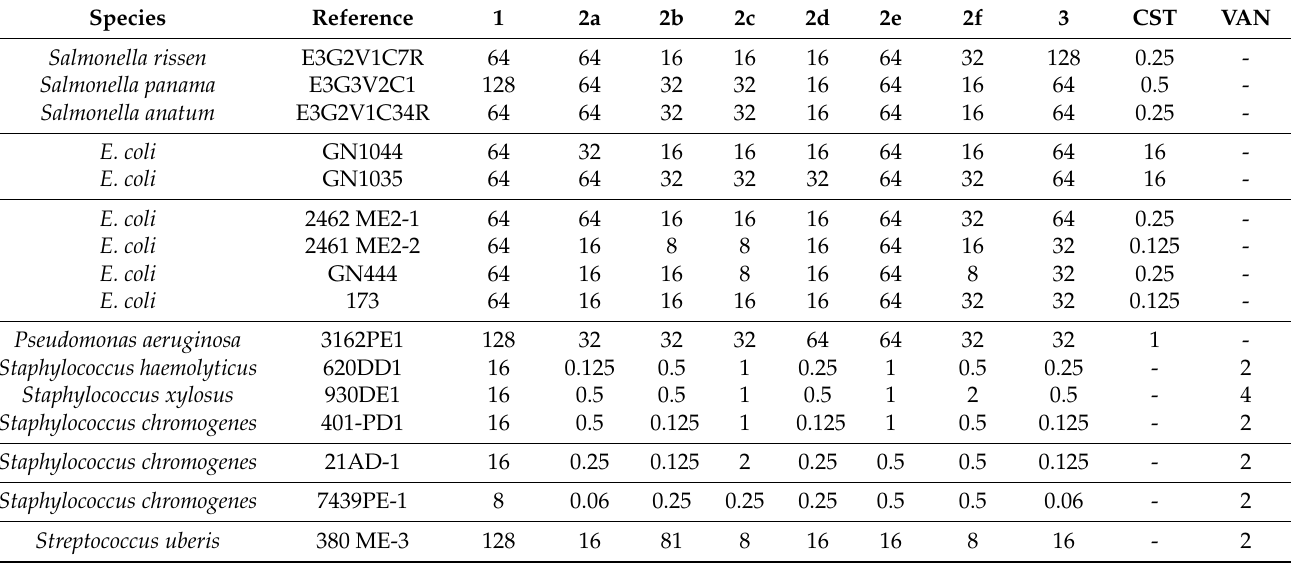
Table 2. Summary of the MBC values (mg/L) of the (CˆS)-cyclometallated Au(III) complexes and standard drugs under